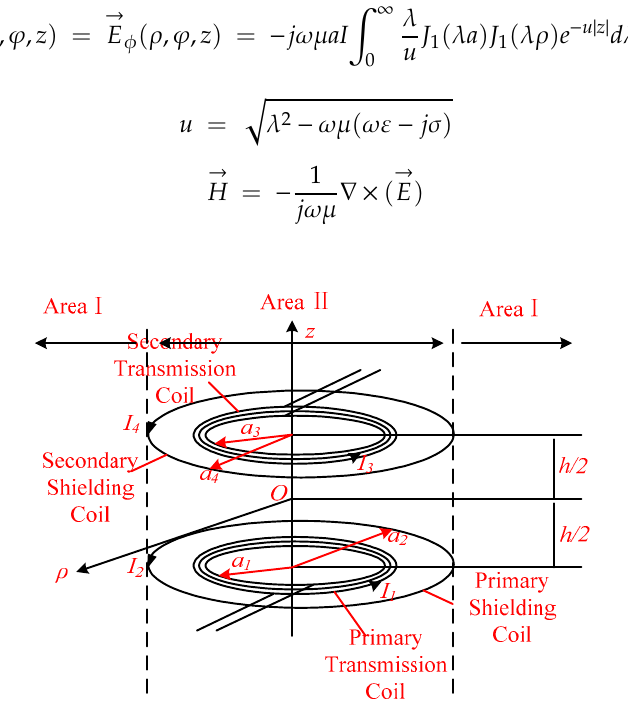
Figure 5. The structure for WPT system with shielding coils.